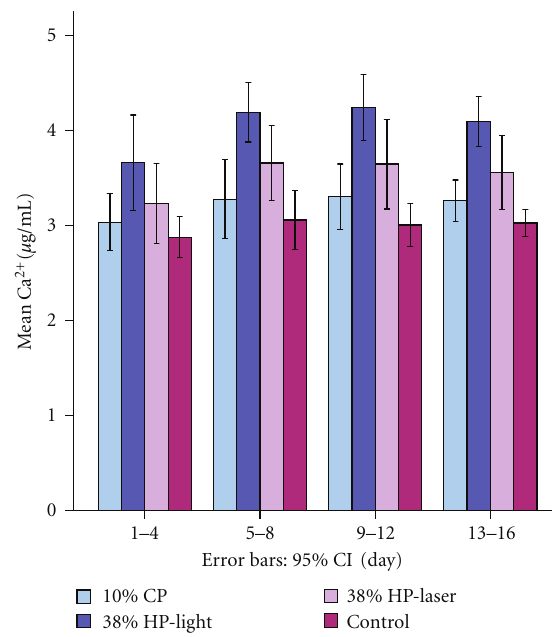
Figure 3: Ca 2+ values measured in the bu ff er solution after applica- tion of bleaching agents.